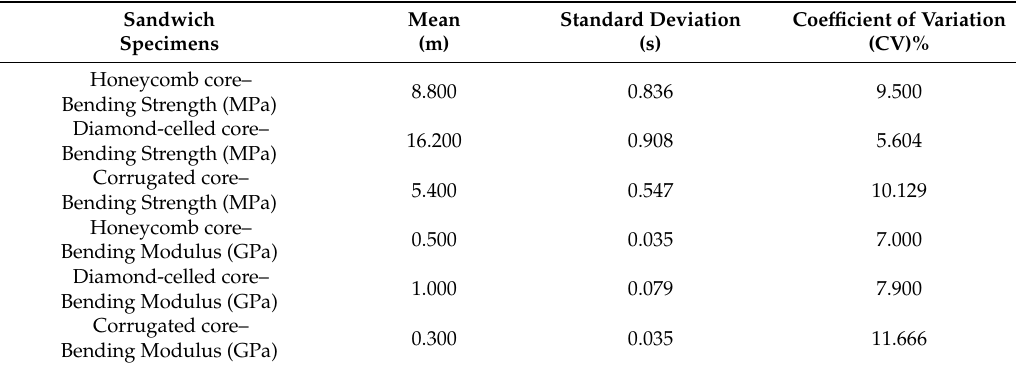
Figure 12. Load–displacement curves obtained from three-point bending tests: ( a ) honeycomb core; ( b ) diamond-cell core; ( c ) corrugated core.